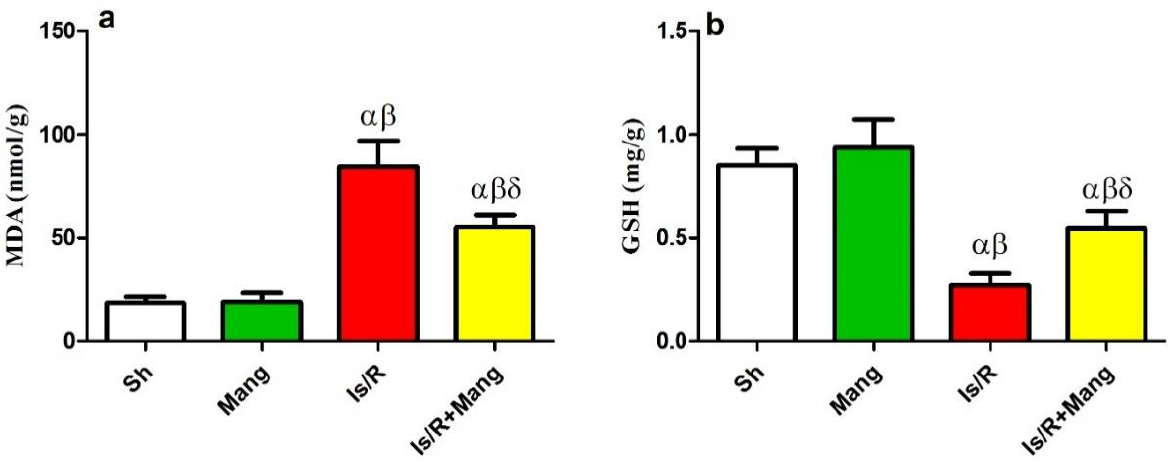
Figure 2. Mang’s (20 mg/kg, i.p) impact on renal ( a ) MDA and ( b ) GSH contents as oxidative stress markers. Data were articulated as the mean ( n = 7) ± SD, p value < 0.05 is significant. As compared with sham ( α ), Mang ( β ), and Is/R ( δ ) treated groups.